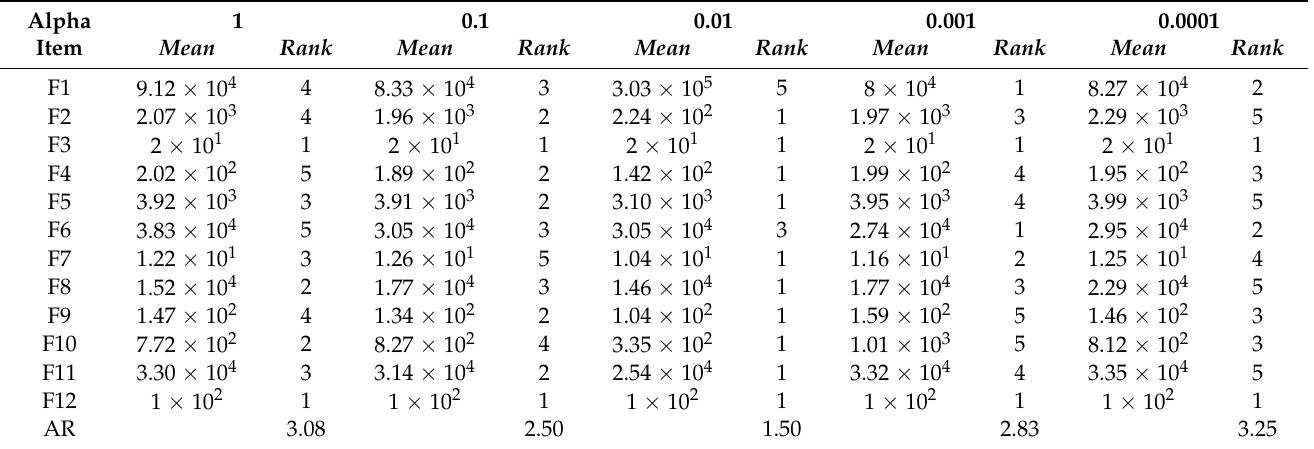
Table 3. Sensitivity analysis for α